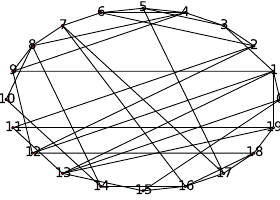
Figure 11. Small-world